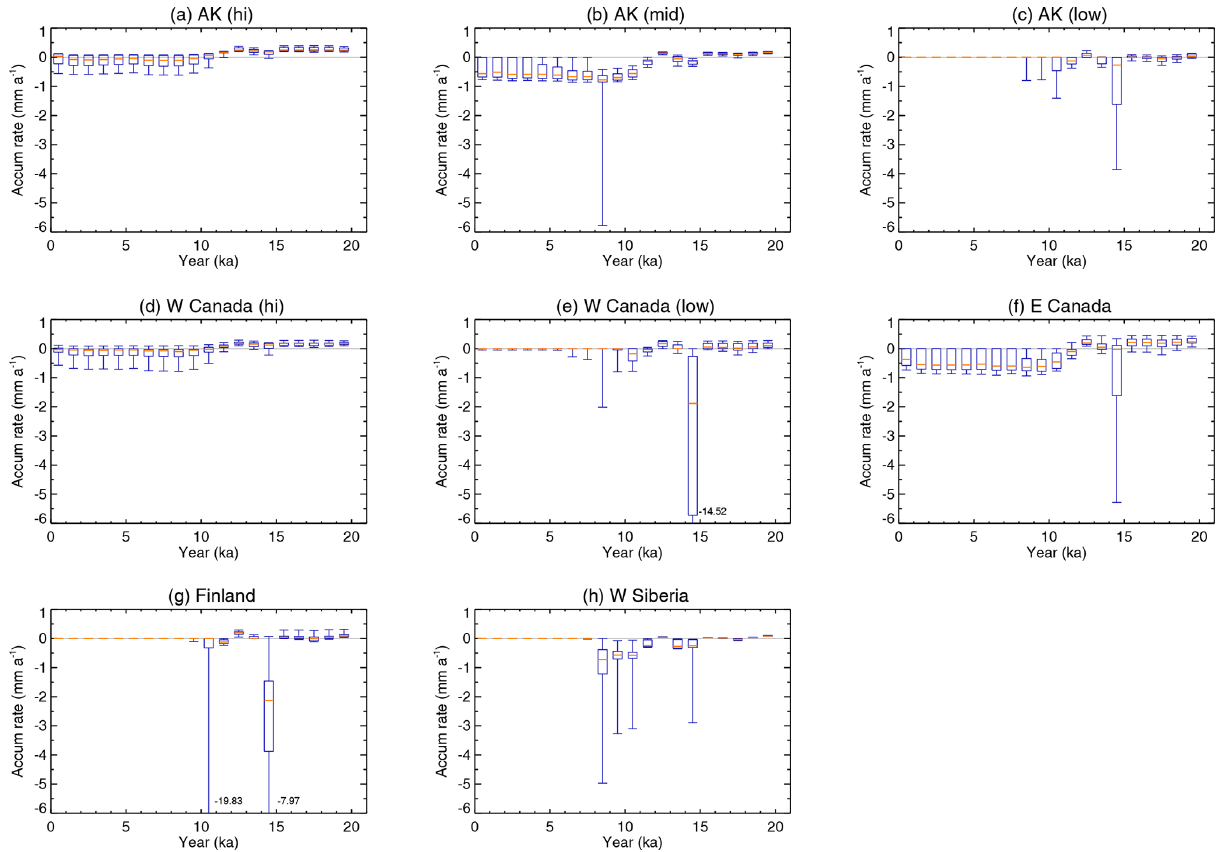
Figure 9. Same as Fig. 8, except for ground ice accumulation in mma − 1